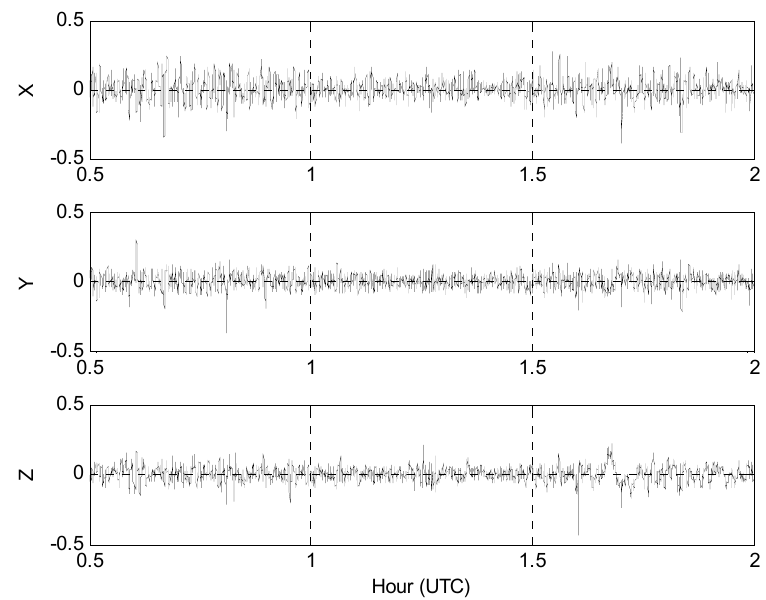
Figure 8. Least squares estimates of the WCF kinematic accelerations in m/s 2 from 2-point averages of the data in Figure 7 with the root-mean-squared (RMS) errors given in Figure 9.